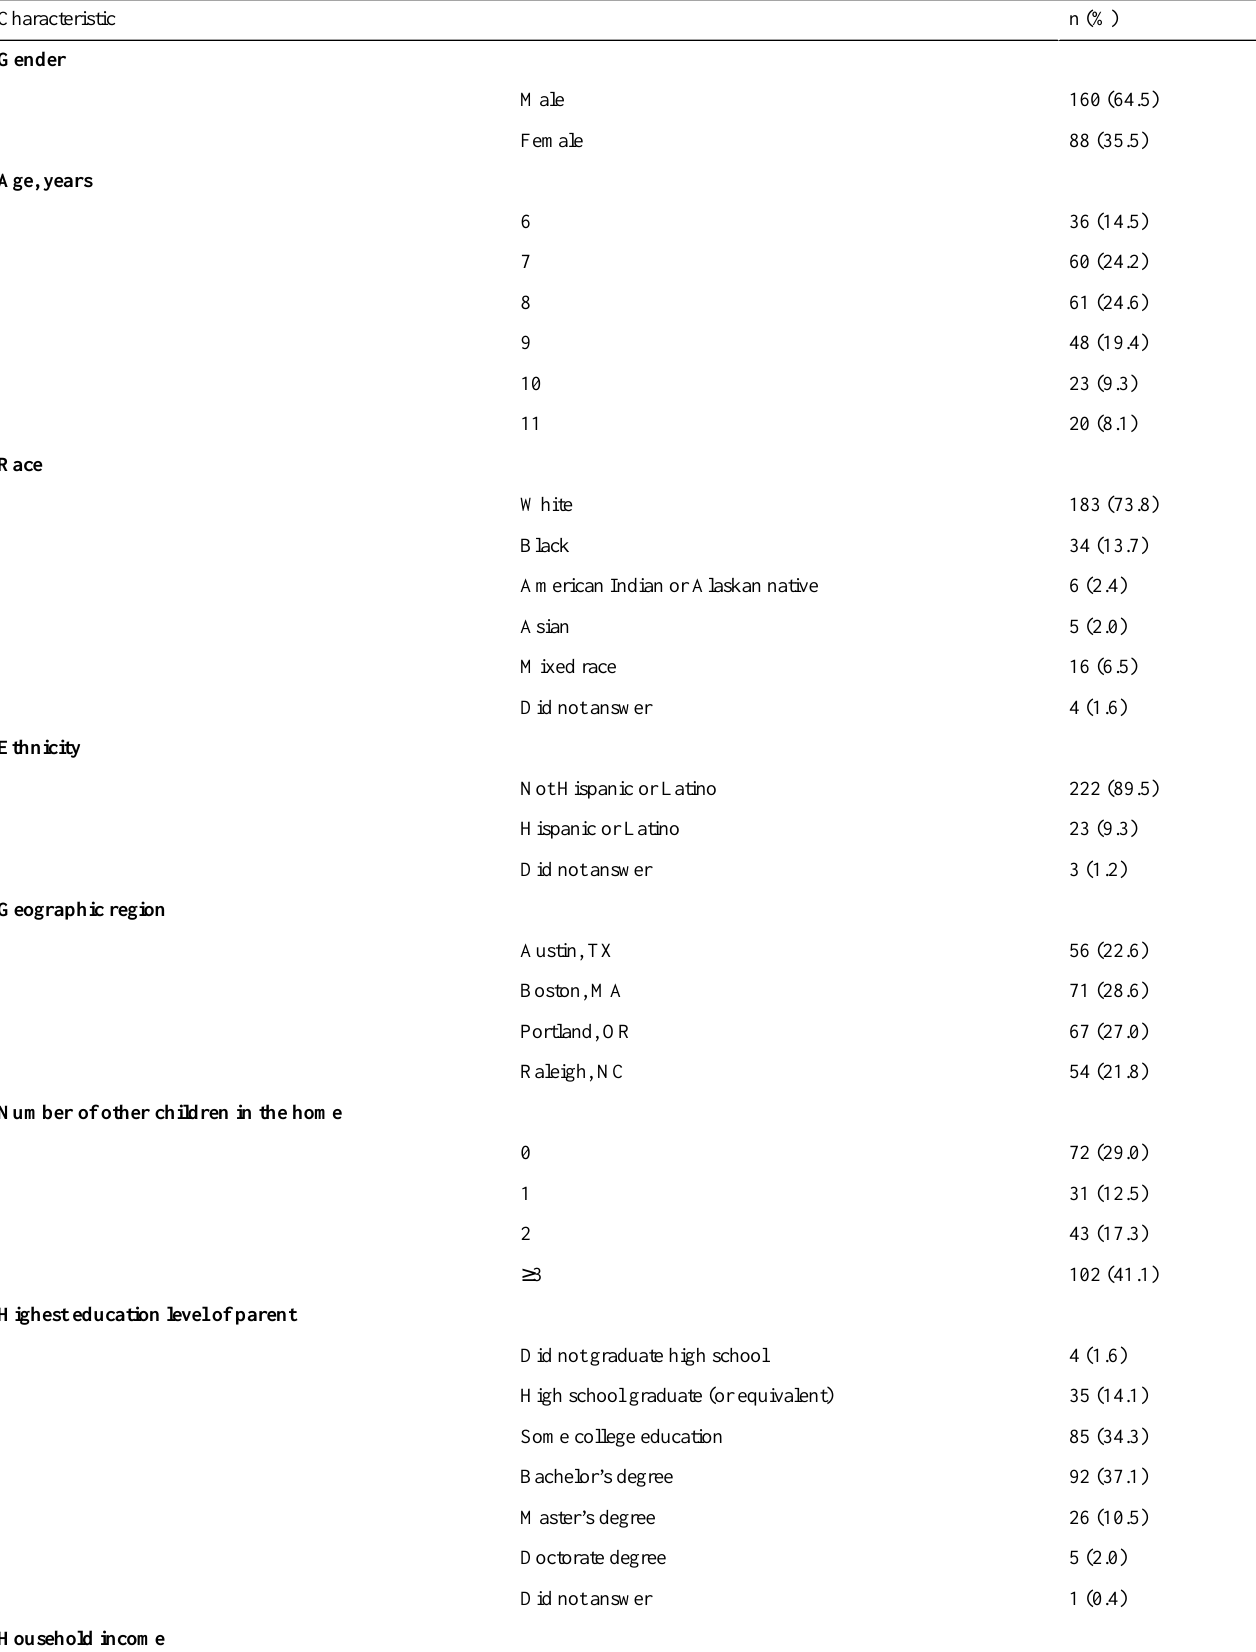
Table 1. Demographic characteristics of enrolled children